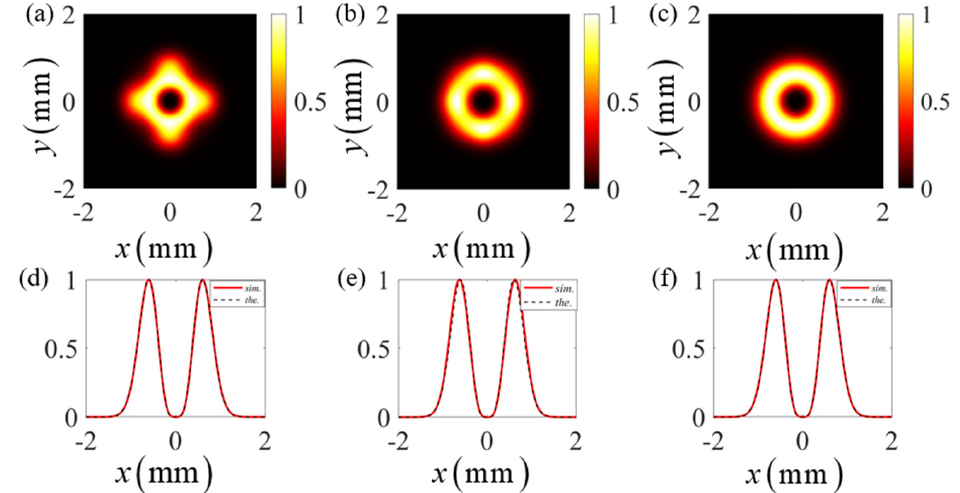
Figure 2. The spatial distributions for the spectral density of a beam synthesized with ( a ) M × N = 5 × 5 pseudo modes, ( b ) M × N = 7 × 7 pseudo modes, and ( c ) M × N = 15 × 15 pseudo modes. The red curves in ( d – f ) show the corresponding cross line ( y = 0) of the simulation results, while the dotted black curves show the corresponding theoretical results.